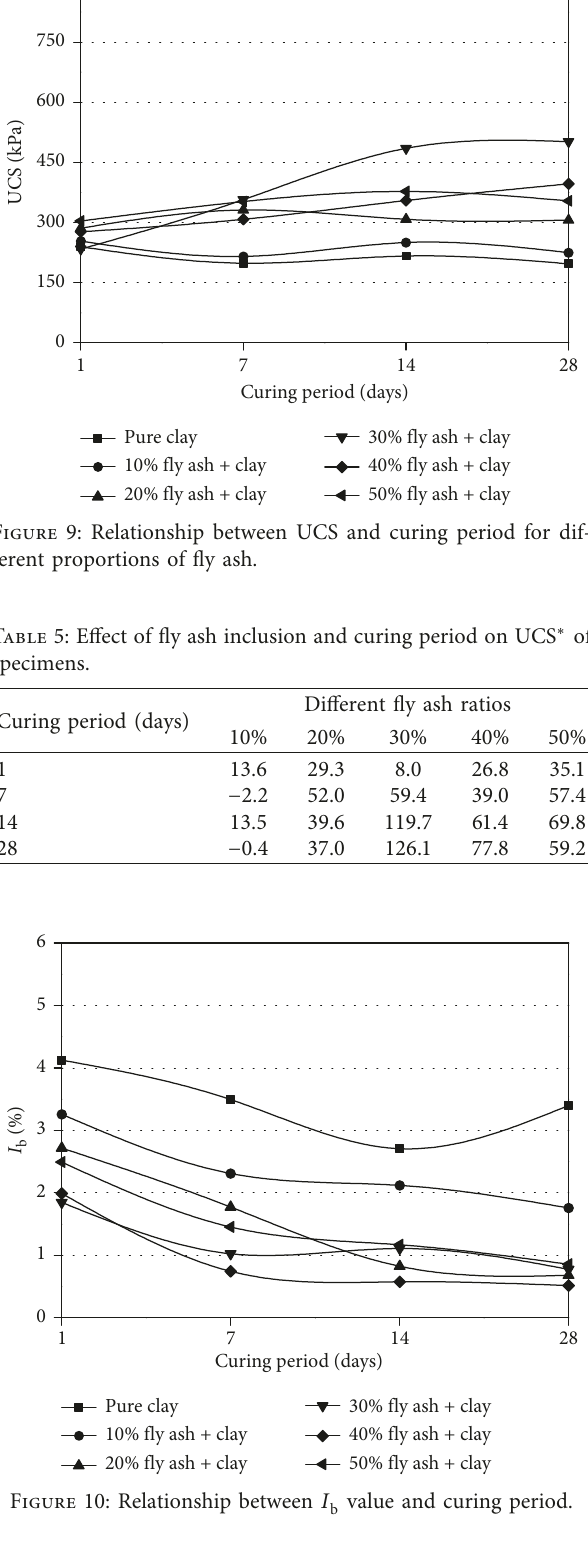
b value and curing period.